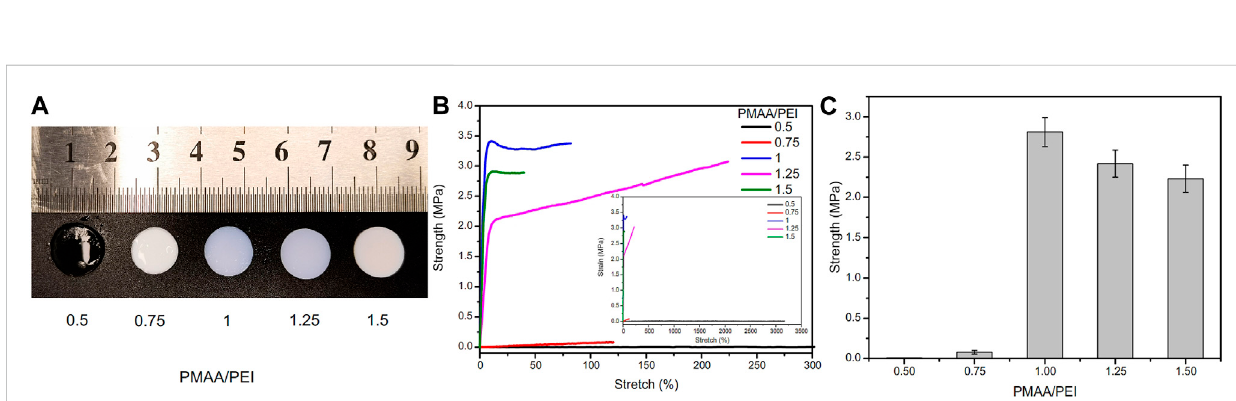
FIGURE 3 Hydrogel samples at different PMAA/PEI molar ratios. (A) Photos of these samples, of which PMAA/PEI = 0.5 is still transparent, while other samples arewhite,indicatingthatthesesampleshaveshownrelativelyobviousphaseseparation; (B) Elongationcurvesofseveralsamples,theillustrationofwhich is a complete force curve, in which the elongation at break of the sample with PMAA. PEI = 0.5 exceeds 3,000%; (C) The breaking strength of gel with